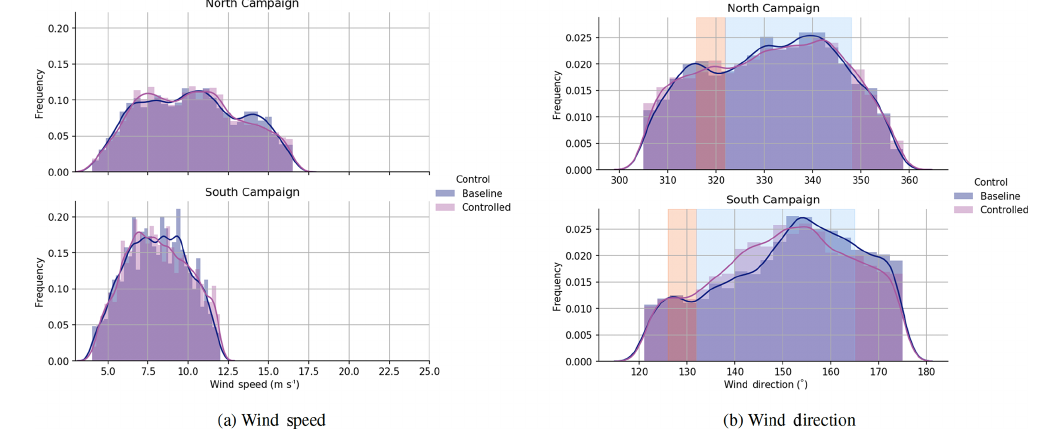
Figure 6. Comparison of wind speed and wind direction histograms, which is divided into baseline and controlled operation. Note that the bands of desired and nondesired yaw offsets first shown in Fig. 5 are used here and throughout the article to illustrate the controlled